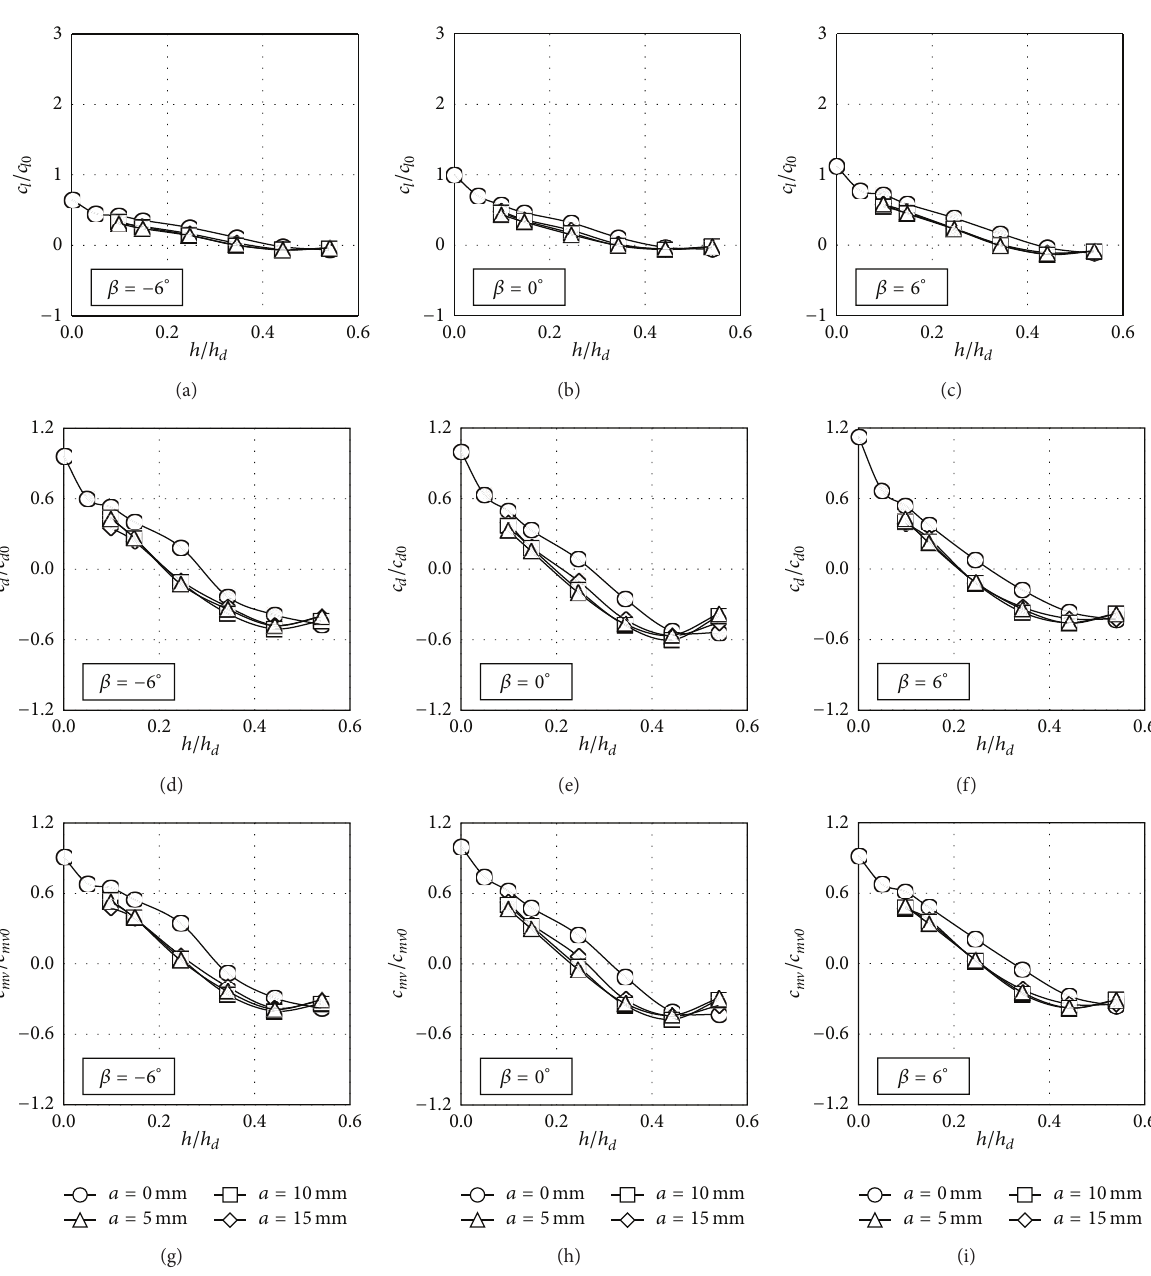
Figure 12: Lift, 𝑐 𝑙 /𝑐 𝑙0 , side force, 𝑐 𝑑 /𝑐 𝑑0 , and rolling moment, 𝑐 𝑚 V /𝑐 𝑚 V 0 , coefficient ratios as a function of the windbreak height, when the train coach is placed on the leeward rail on the embankment with slope 1: 2. Four eave lengths are considered, 𝑎 = 0 mm (circles), 𝑎 = 5 mm (rhombi), 𝑎 = 10 mm (squares), and 𝑎 = 15 mm (triangles). Each column represents a different coach rolling angle, 𝛽 = −6 ∘ (left), 𝛽 = 0 ∘ (centre), and 𝛽 = 6 ∘